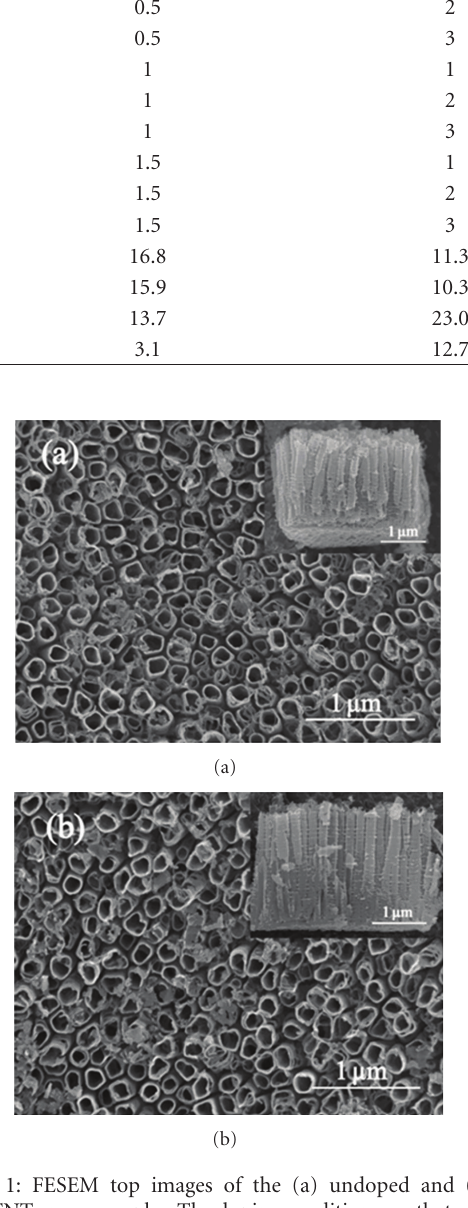
Figure 1: FESEM top images of the (a) undoped and (b) N- doped TNT arrays samples. The doping conditions are that reaction voltage is 3V, reaction time 3h, and electrolyte concentration 0.5 M. The insets show the corresponding cross-sectional images.